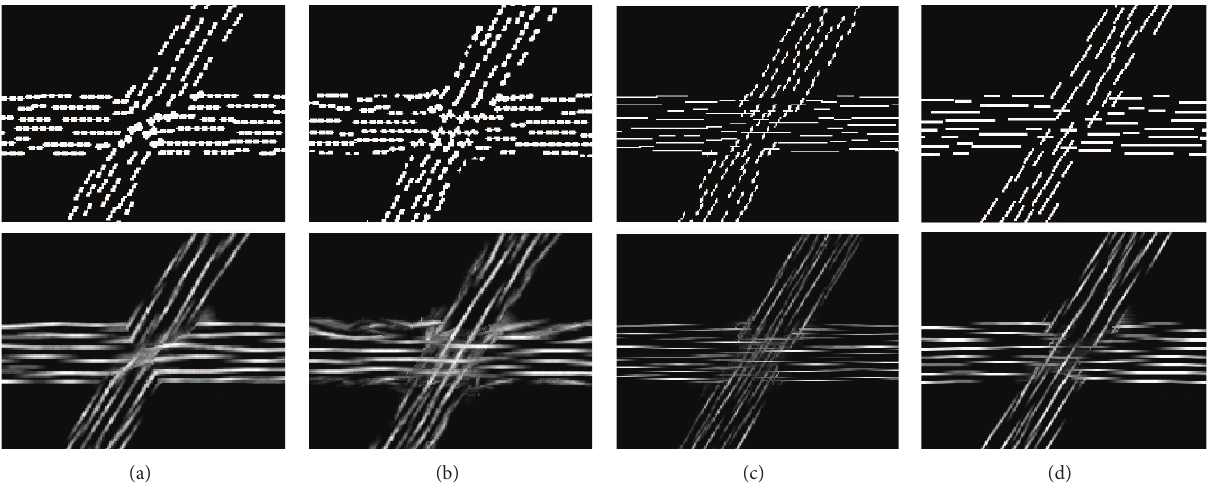
Figure 11: Results from the use of ODF (a), ASSR-sharpened ODF (b), FOD (c), and multiple cylinders (d). Input patterns (top) and their LIC results (bottom).